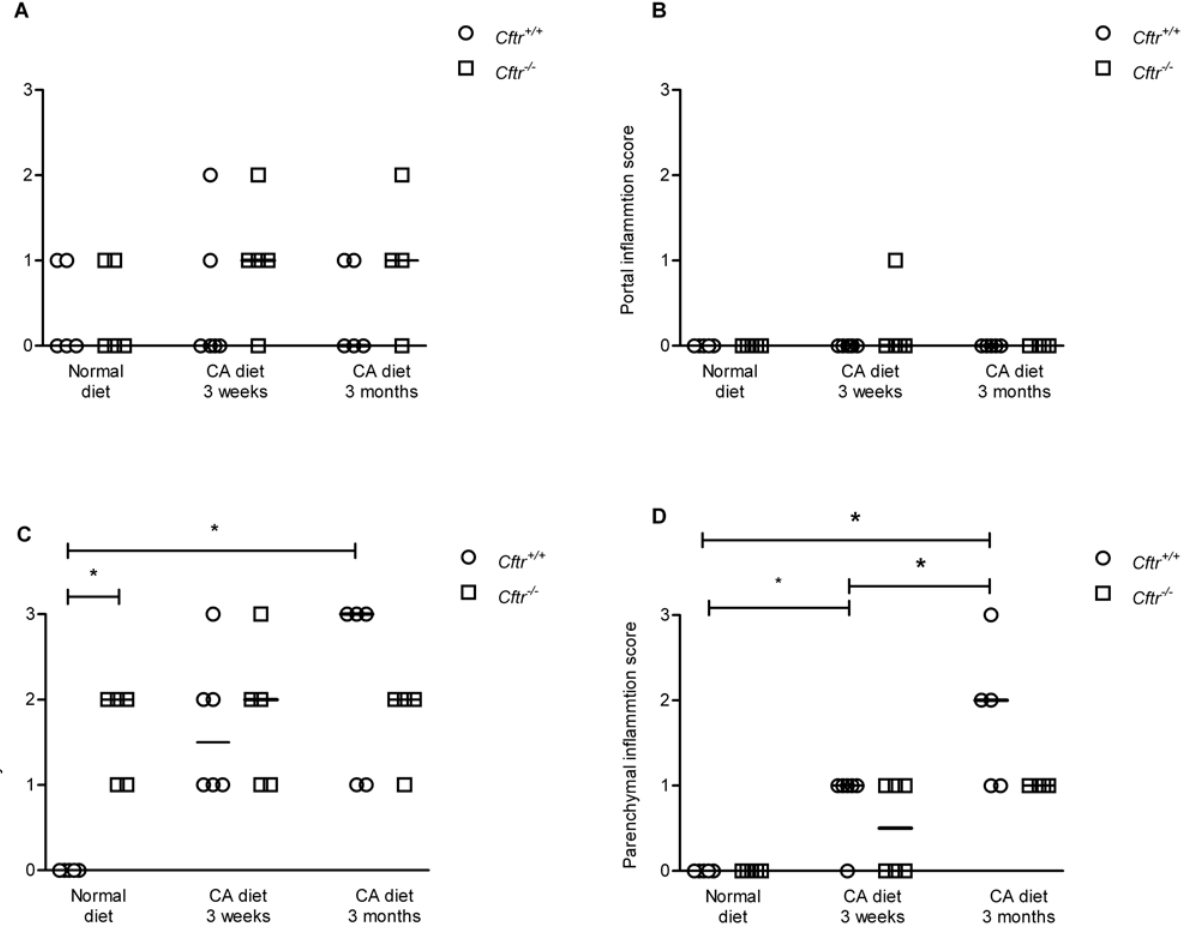
Fig 5. Liver histology in Cftr knockout mice (Cftr -/- ) and controls, fed a control diet or a cholic acid (CA) containing diet for 3 weeks or for 3 months. Histological evaluation of liver parenchymal inflammation (A), parenchymal Ki67 activity (B), portal inflammation (C), and portal Ki67 activity (D), in Cftr knockout mice ( Cftr -/- ) and control littermates ( Cftr +/+ ) after a control diet, a 0.5%-CA (wt/wt) chow diet for three weeks, or a 0.5%-CA (wt/wt) chow diet for three months. Histology was scored in a blinded and semi-quantitative fashion using an ordinal scale (0: absent; 1: sporadic; 2: regular; 3: frequent). All results are presented individually per mouse; the horizontal black line represents the median of N = 5 – 7 mice per group. * P-value <